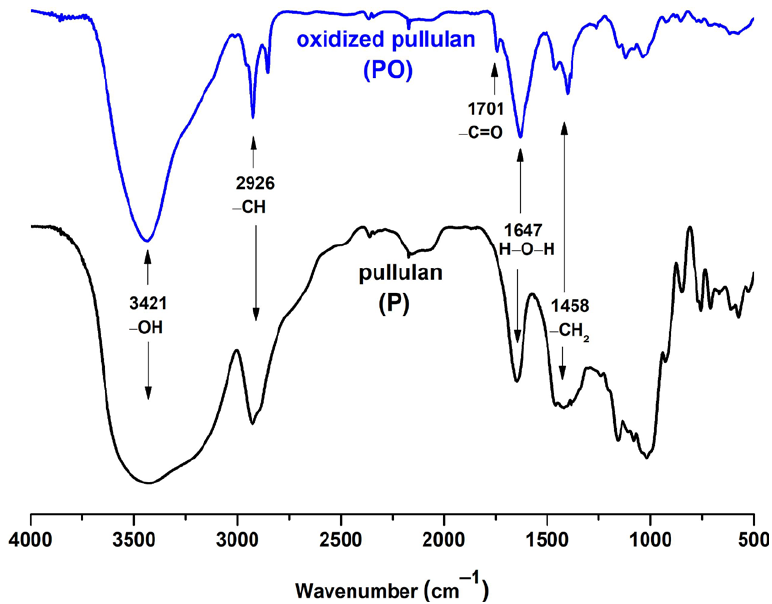
Figure 2. FTIR spectra of pullulan ( bottom ) and its TEMPO-mediated oxidation product ( top ).